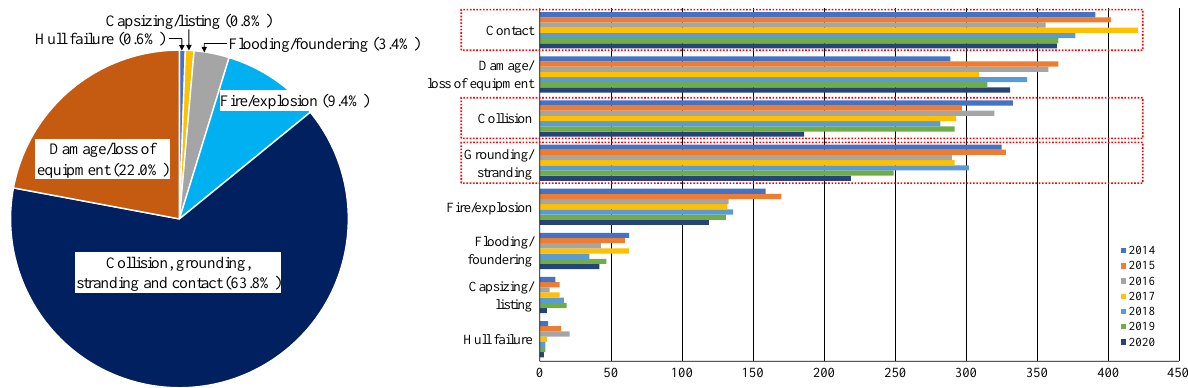
Figure 1. Distribution of maritime casualty accidents over 2014 – 2020 (reproduced from [1], with permission from EMSA 2022).